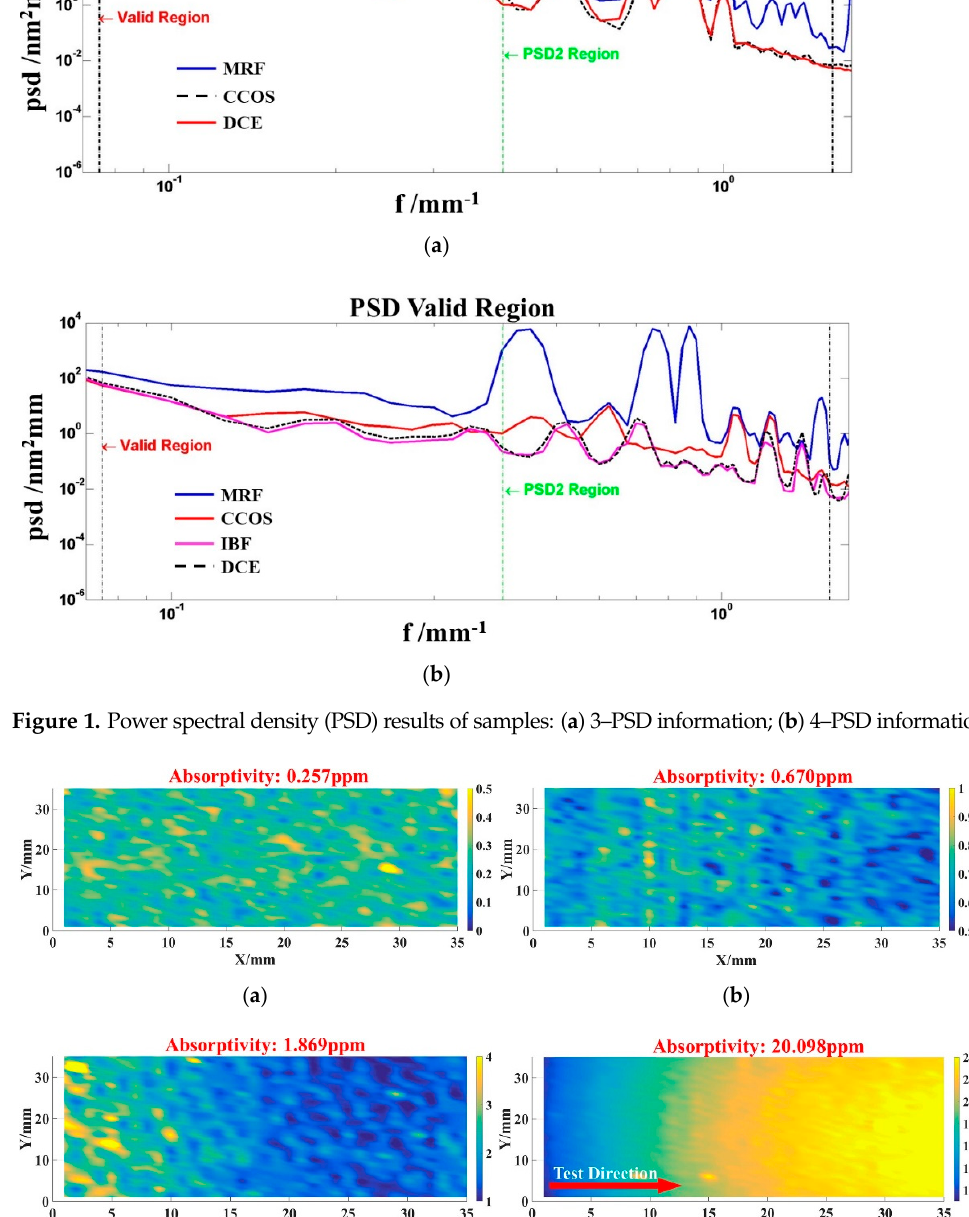
( d ) Figure 3. Absorptivity result of samples after DCE process: ( a ) 1 — absorptivity result; ( b ) 2 — absorp- tivity result; ( c ) 3 — absorptivity result; ( d ) 4 — absorptivity result. 3.3. Laser Induced Damage Test In order to explore the changes of anti-laser damage characteristics of optics under different techniques, an LIDT platform was used to detect the damage threshold of sample